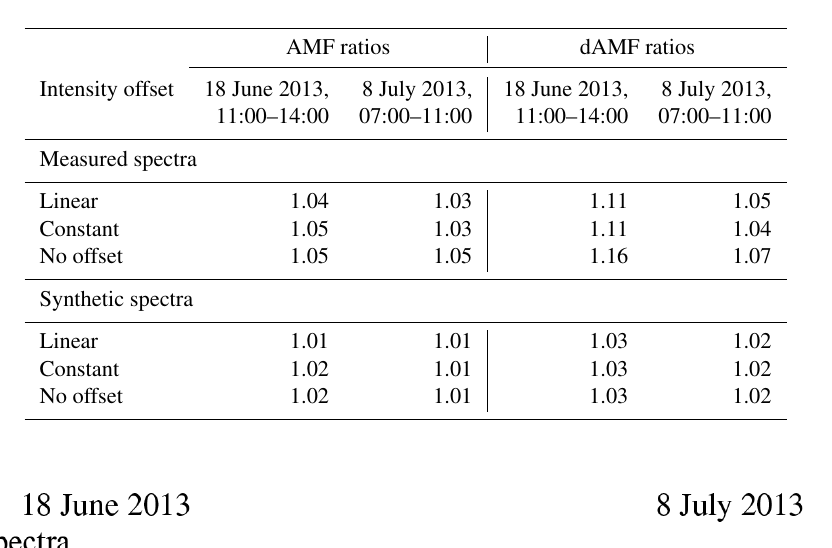
Table A16. Average ratios of O 4 (d)AMFs derived for different intensity offsets vs. those for the standard analysis (intensity offset of degree 2) for the middle period on each selected day (top: results for spectra measured by the MPIC instrument; bottom: results for synthetic spectra when taking into account the temperature dependence of the O 4 cross section).